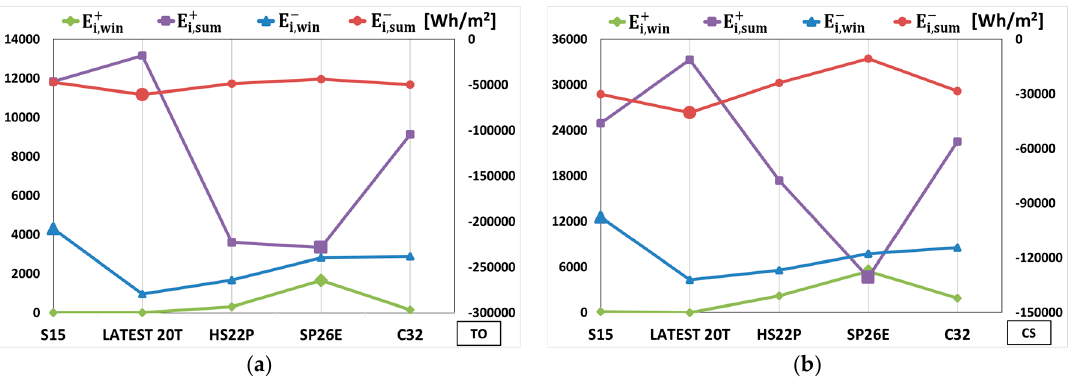
Figure 7. Seasonal energies entering (cid:1831) (cid:3036),(cid:3050)(cid:3036)(cid:3041)(cid:2878) and (cid:1831) (cid:3036),(cid:3046)(cid:3048)(cid:3040)(cid:2878) the air-conditioned environment and energies exiting (cid:1831) (cid:3036),(cid:3050)(cid:3036)(cid:3041)(cid:2879) and (cid:1831) (cid:3036),(cid:3046)(cid:3048)(cid:3040)(cid:2879) from the air-conditioned environment, for the different PCMs taken into consideration, for Turin ( a ) and Cosenza ( b ).